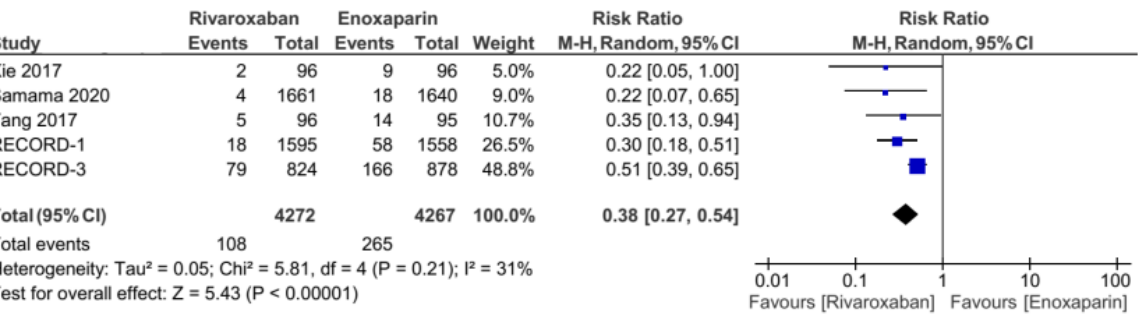
Figure 2. Incidence of any VTE and all-cause death [5,7,12 – 14].